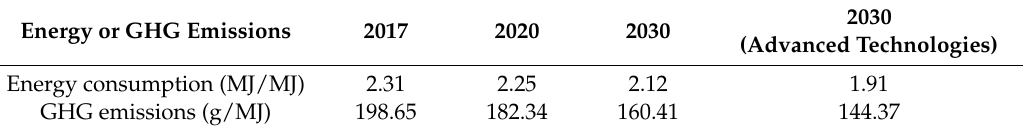
Table 9. Energy and emission intensities of power generation in 2020 and 2030.